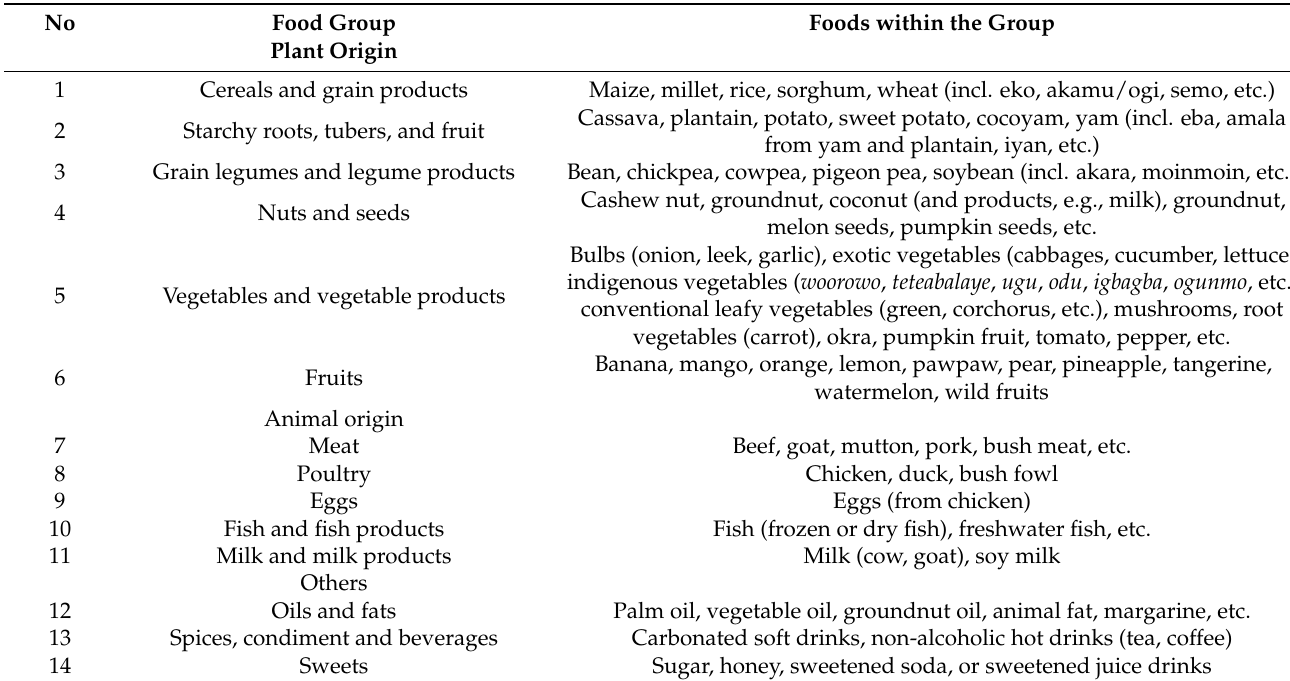
Table 1. Food groups included in the